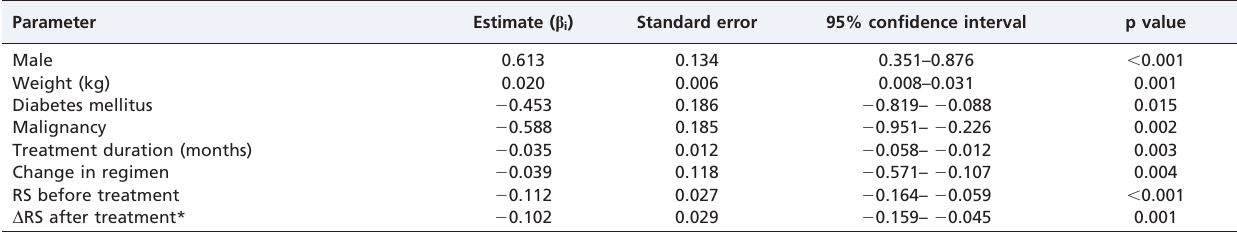
Table 3 - Predictors of FVC within 60 months after completion of treatment for pulmonary